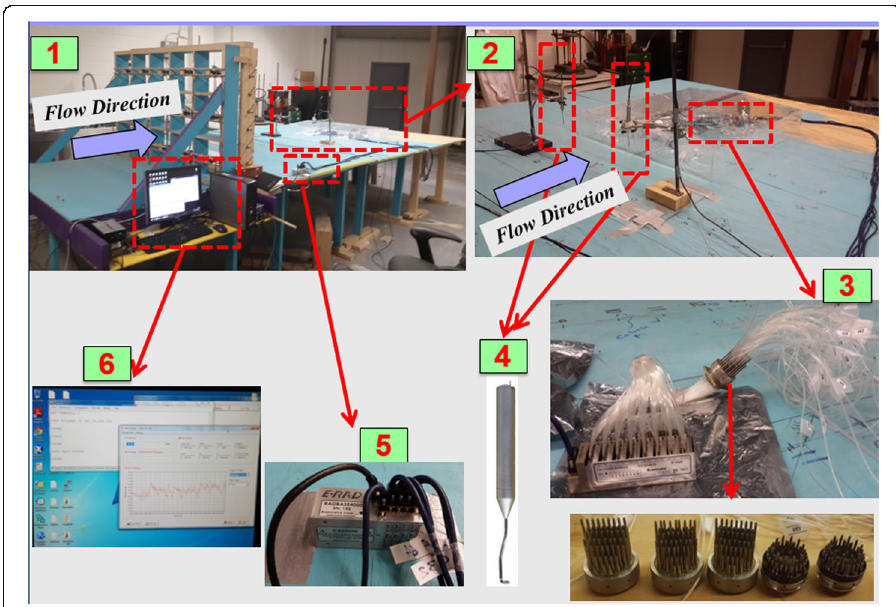
Fig. 7 Experimental setup: ( 1 ) general view of the open-jet simulator, ( 2 ) instrumented test model, ( 3 ) view of a pneumatic connector, ( 4 ) cobra probe, ( 5 ) ZOC miniature electronic pressure scanning module, and ( 6 ) instantaneously measured